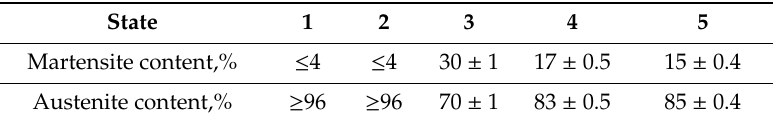
Table 3. Phase Composition of Steel in the Studied States.